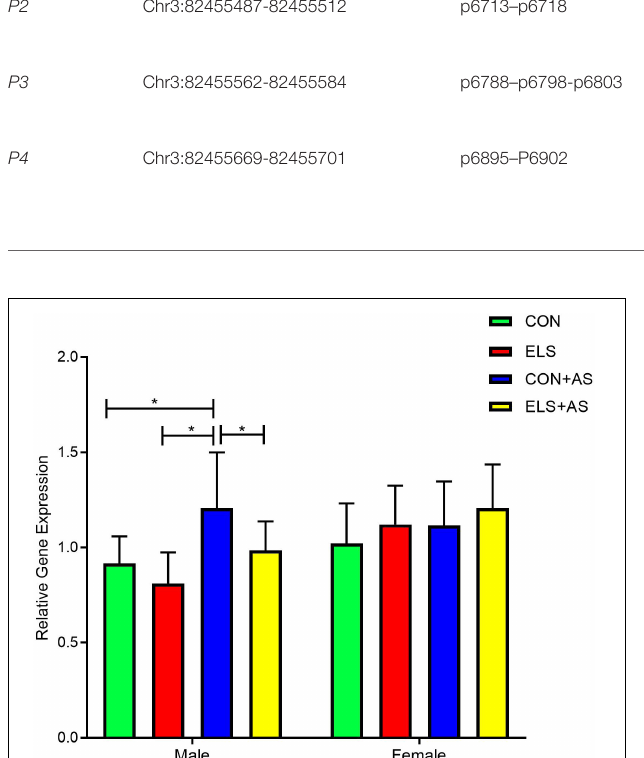
FIGURE 3 | Analysis of Y2 receptor gene expression after ELS and AS in the hippocampus of male and female animals. Significant results of post hoc test (SNK) are represented as * p ≤ 0.05. CON, control; ELS, early life stress; CON+AS, control + adult stress; ELS+AS, early life stress + adult